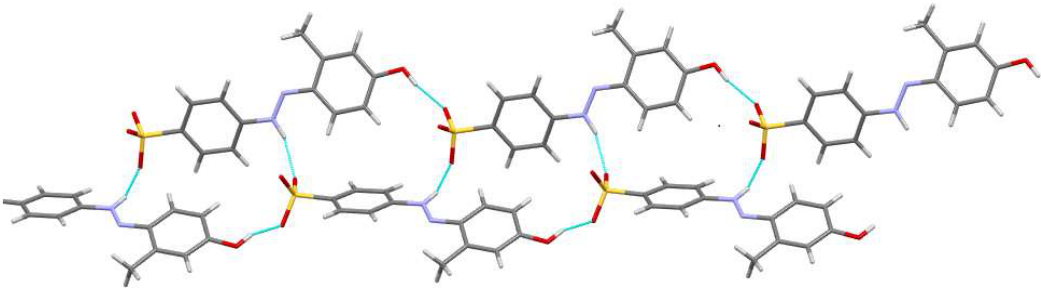
Figure 7. Part of the 1-dimensional hydrogen bonding network formed from R 3 3 (20) rings. This example is drawn from the α polymorph of H4 , but is common to all the anhydrous free acid forms with protonation of the azo group and an OH substituent on an aromatic ring.